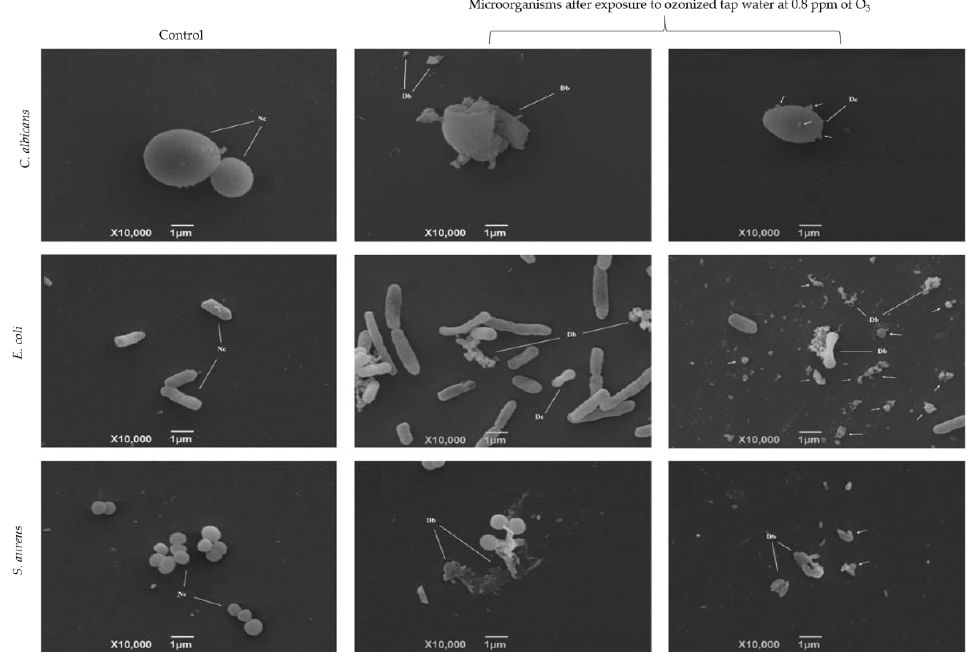
Figure 8. Scanning electron microscopy of C. albicans , E. coli , and S. aureus non-treated or treated with ozonized tap water at 0.8 ppm of O 3 . Microorganisms used in the test are displayed in left side of the chart. Conditions (control or test) for the assay are shown above. Normal cells (Nc), cell deformity (Dc), and cellular debris (Db) are indicated in the pictures. Arrows were added to the images to highlight other Db in the slides.